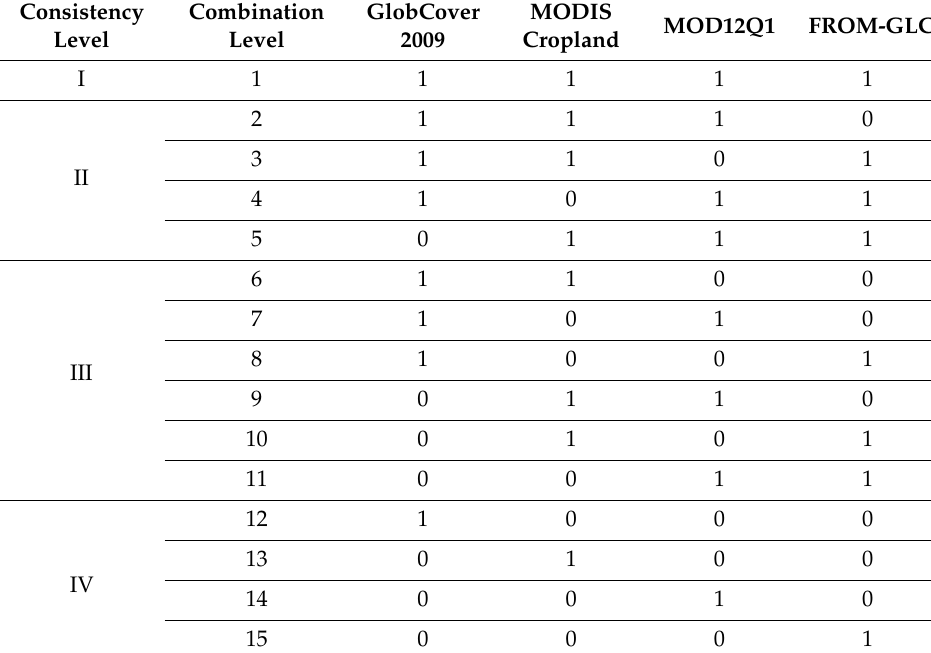
Figure 3. Spatial distribution of the consistency level. Table 2. Fusion combination level table.